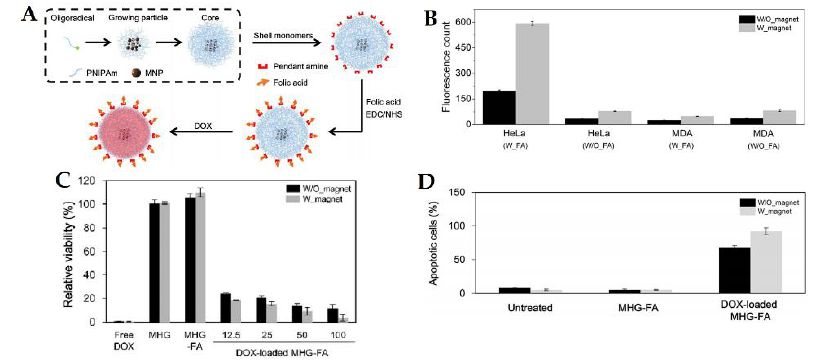
Figure 5. ( A ) Schematic representation of the magnetogel preparation by precipitation polymerization with conjugation of folic acid via EDC/NHS (1-Ethyl-3-(3-dimethylaminopropyl)carbodiimide/N- Hydroxysuccinimide) chemistry and loaded with doxorubicin. ( B ) Quantitative cellular uptake of magnetogels by HeLa and MDA-MB-231 cells with and without and externally applied magnetic field and with or without folic acid. ( C ) Relative viability of HeLa cells treated with free doxorubicin (DOX) (100 μg/mL), magnetogel (MHG) (100 μg/mL), magnetogel with folic acid (MHG -FA) (100 μg/mL) and DOX-loaded MHG- FAs at various concentrations (12.5, 25, 50 and 100 μg/mL), treated for 30 min with or without externally applied magnetic field and incubated for 96 h. ( D ) Apoptosis percentage of HeLa cells treated with 100 μg/mL MHG -FA or DOX-loaded MHG-FA for 30 min and further incubated for 48h. Adapted from Kim et al. [44], Nature Publishing Group, 2017 (available under Open Access).